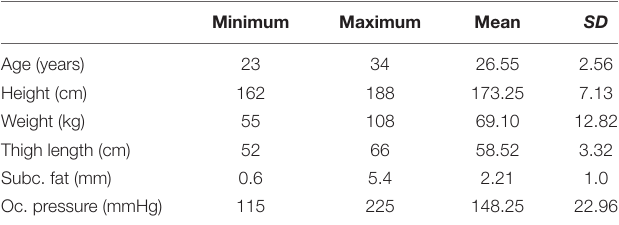
N = 20, Women = 11, Men = 9. Subc. fat = subcutaneous fat, SD = standard deviation, Oc. Pressure = occlusion pressure, mmHg = millimeters of